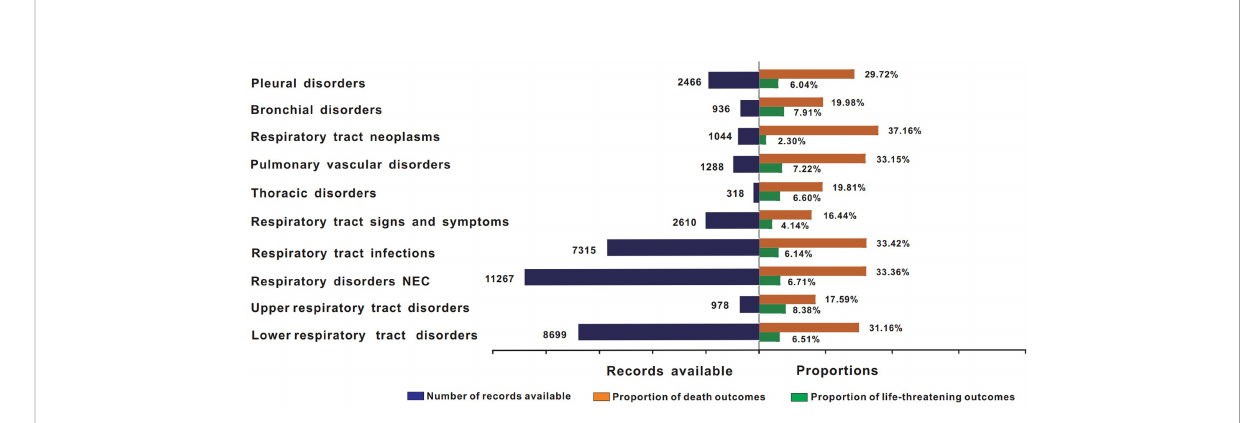
FIGURE 3 Records and proportions of death in class-speci fi c respiratory system AEs. AEs, adverse events; ICIs, immune checkpoint